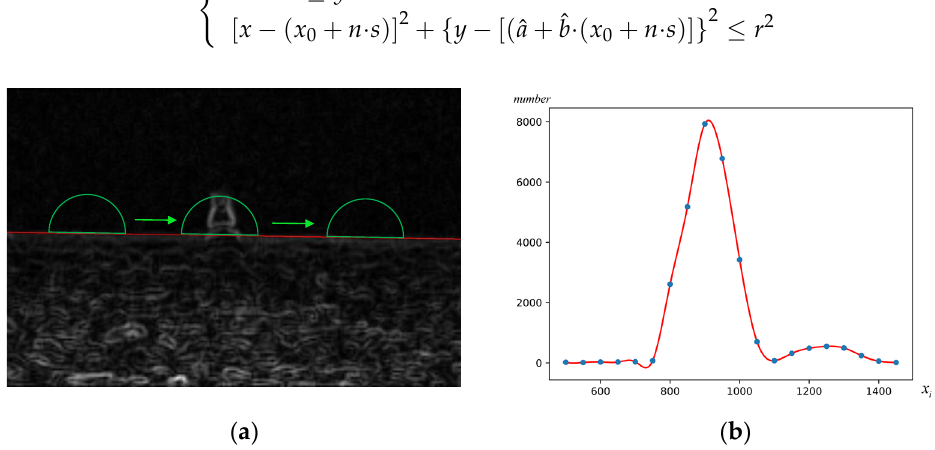
Figure 11. Target area extraction results: ( a ) target extraction process based on sea-sky line; ( b ) bright